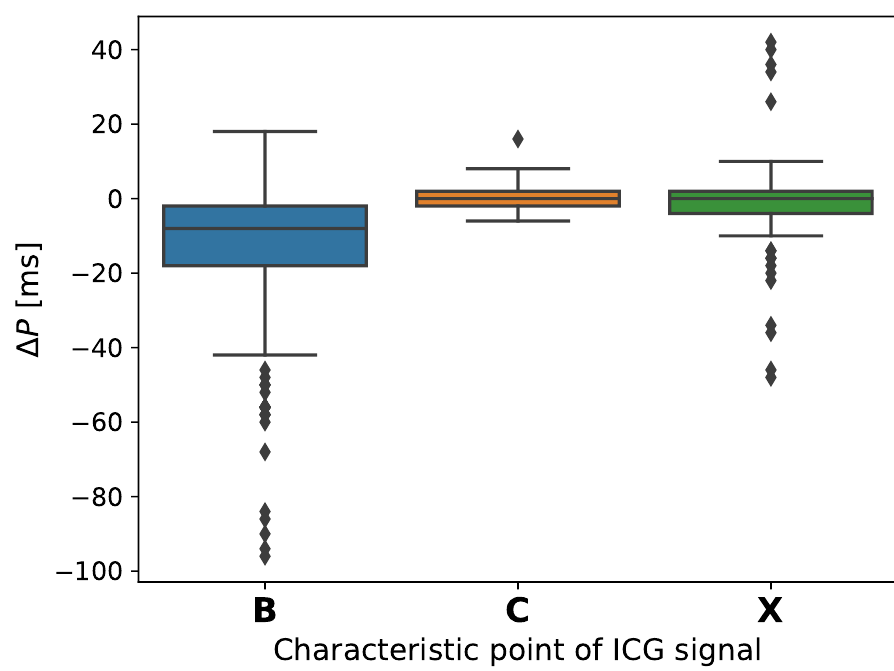
Figure 7. Detection error ( ∆ P [ms]) for the ICG fiducial points.